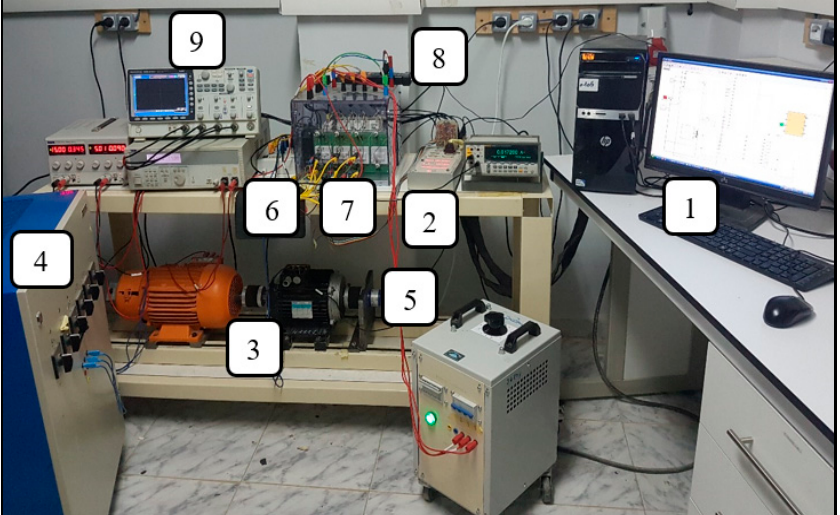
Figure 16. Experimental setup.